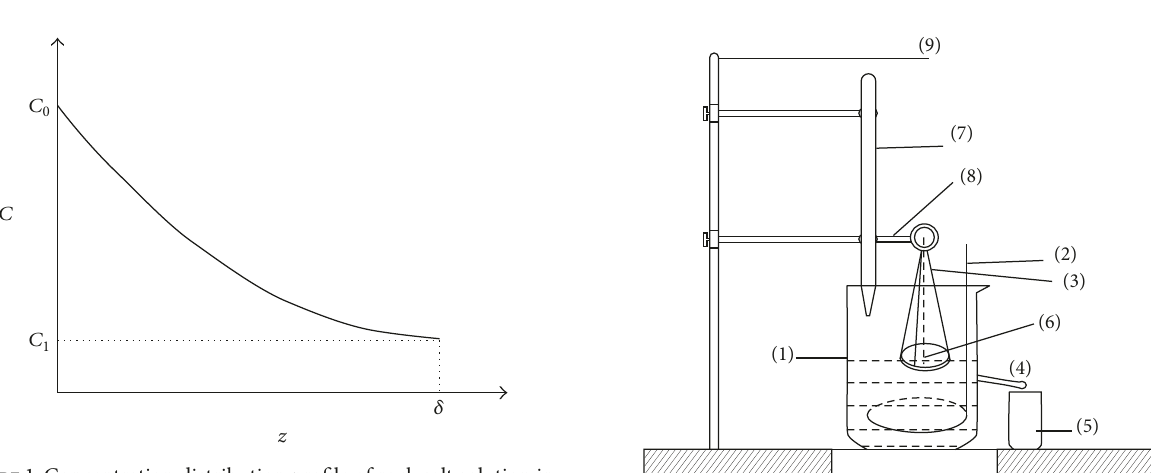
Figure 1: Concentration distribution profile of rock salt solution in the dissolution boundary layer. The horizontal axis is the distance from the wall surface of rock salt in the normal direction ( 𝛿 ) and the vertical axis is the concentration ( 𝐶 ).